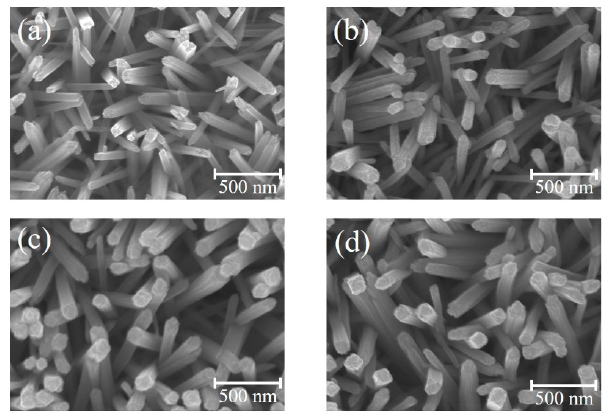
Figure 1. SEM images of various nanorod samples: ( a ) TiO 2 ; ( b ) TiO 2 –ZFO-1; ( c ) TiO 2 –ZFO-2; ( d ) TiO 2 –ZFO-3.